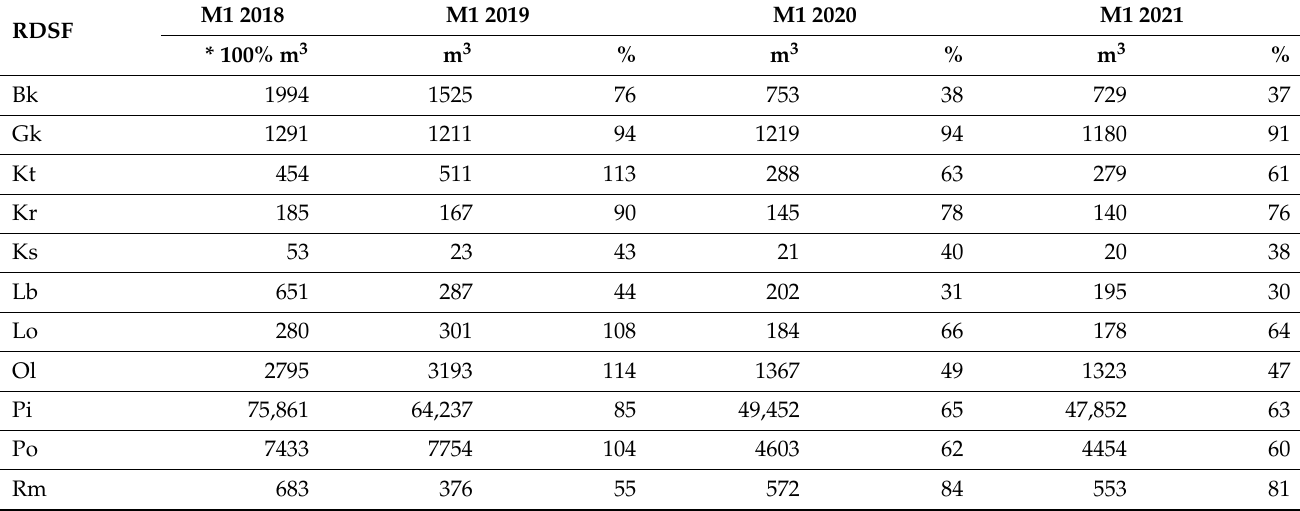
Table 5. Presentation of the structure of M1w wood biomass from